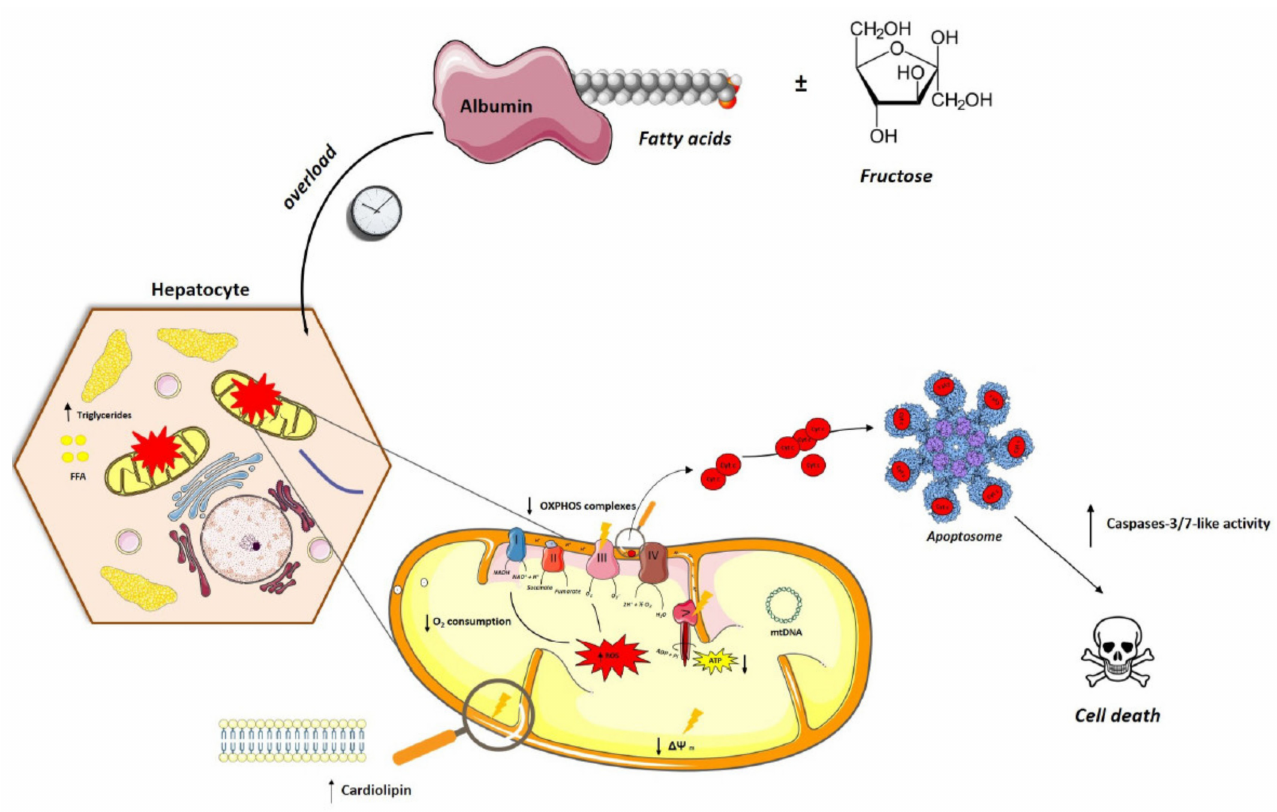
Figure 8. Proposed mechanism for fatty acid overload and mitochondrial dysfunction on human hepatocytes. FA overload are toxic and trigger a time-dependent caspase apoptotic cell death. The progressive increase in neutral lipids content and phospholipid modifications in mitochondria, followed by a large increase in ROS levels compromise mitochondrial function (decrease in ∆Ψ m, O 2 consumption, and OXPHOS protein levels). Mitochondrial impairment can potentiate even more ROS production. ROS itself, or in conjugation with mitochondrial dysfunction, can lead to activation of caspase-dependent apoptotic cell death pathways. Thus, fatty acid overload led to a time-dependent decrease in cell